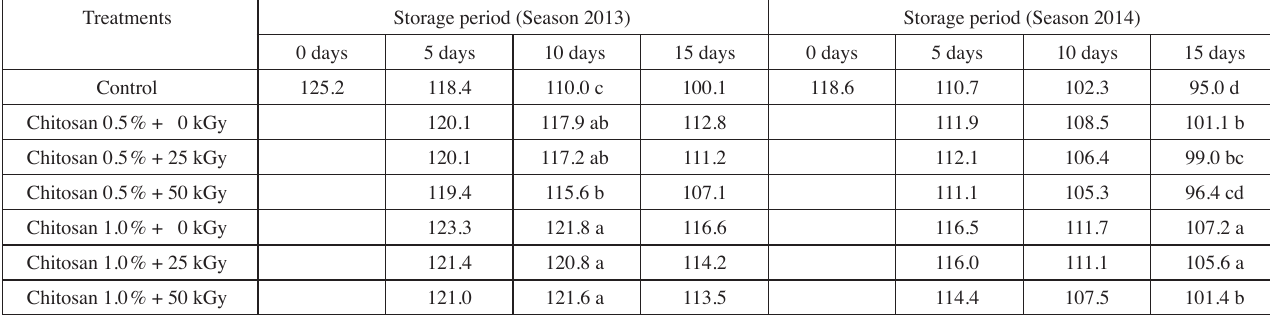
Tab. 3: Effect of irradiated and unirradiated chitosan on arils juice vitamin C content (mg ascorbic acid 100 ml -1 juice) during cold